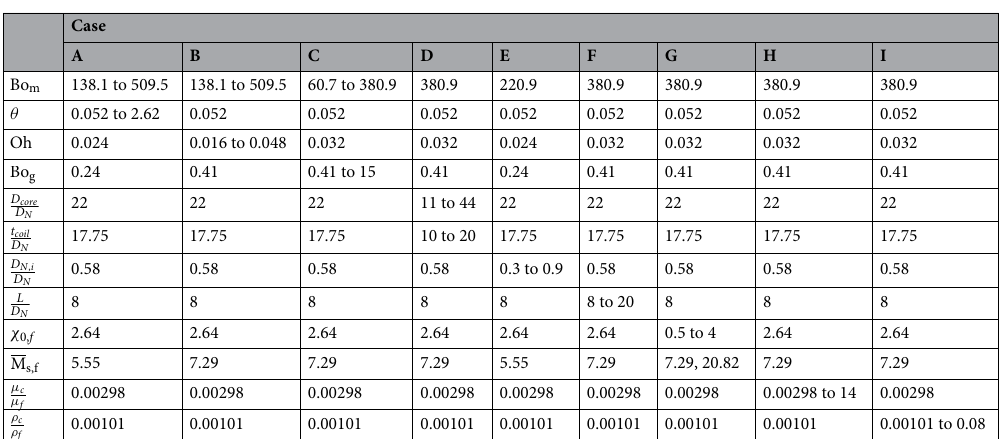
Table 1. Selected values and variation intervals of dimensionless numbers.